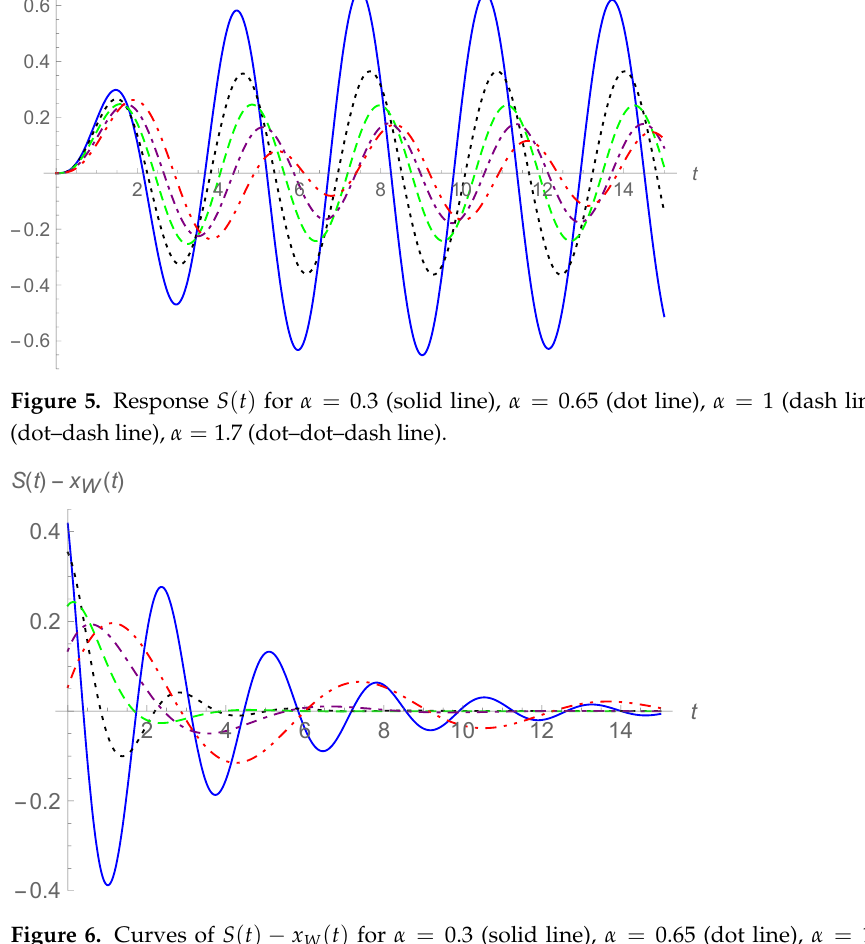
Figure 6. Curves of S ( t ) − x W ( t ) for α = 0.3 (solid line), α = 0.65 (dot line), α = 1 (dash line), α = 1.35 (dot–dash line), α = 1.7 (dot–dot–dash